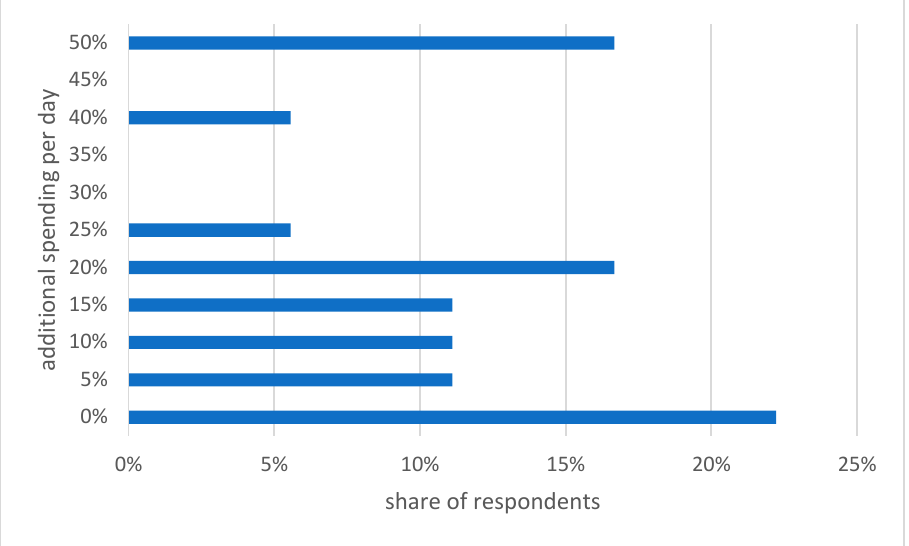
Figure 5. Willingness to spend more on products or services in the vicinity of the coworking space compared to out-of-town offerings.